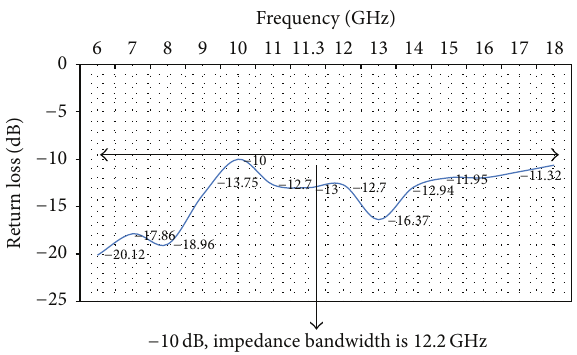
Figure 6: Return losses versus